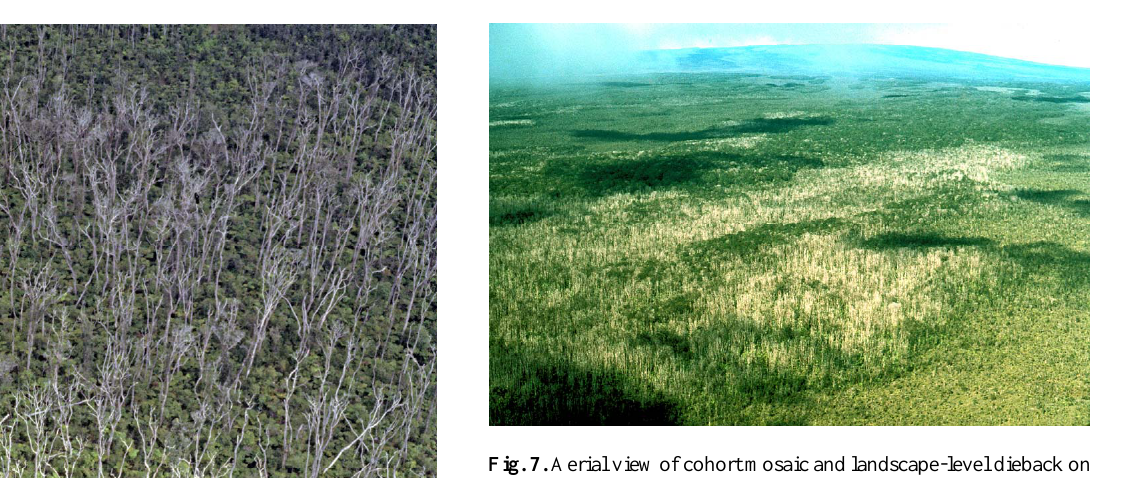
Fig. 7. Aerial view of cohort mosaic and landscape-level dieback on east slope of Mauna Loa (photo by James D. Jacobi, January 1983).